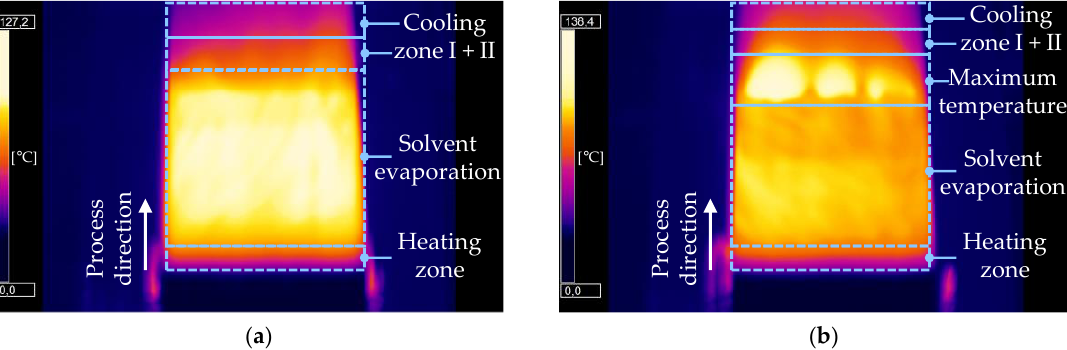
Figure 2. Thermographic monitoring of the laser-drying process for silicon–graphite anodes containing 10 w solid -% silicon ( a ) at process parameter set V (low laser intensity), ( b ) at process parameter set VI (high laser intensity).